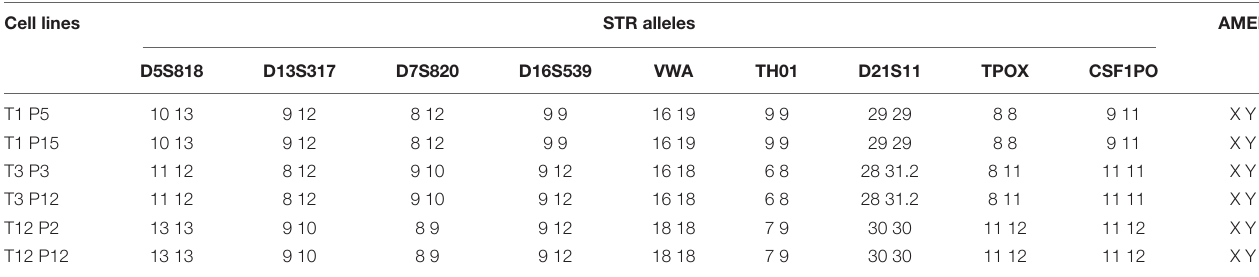
TABLE 3 | STR analysis of three representative CRCs at different passages. Cell